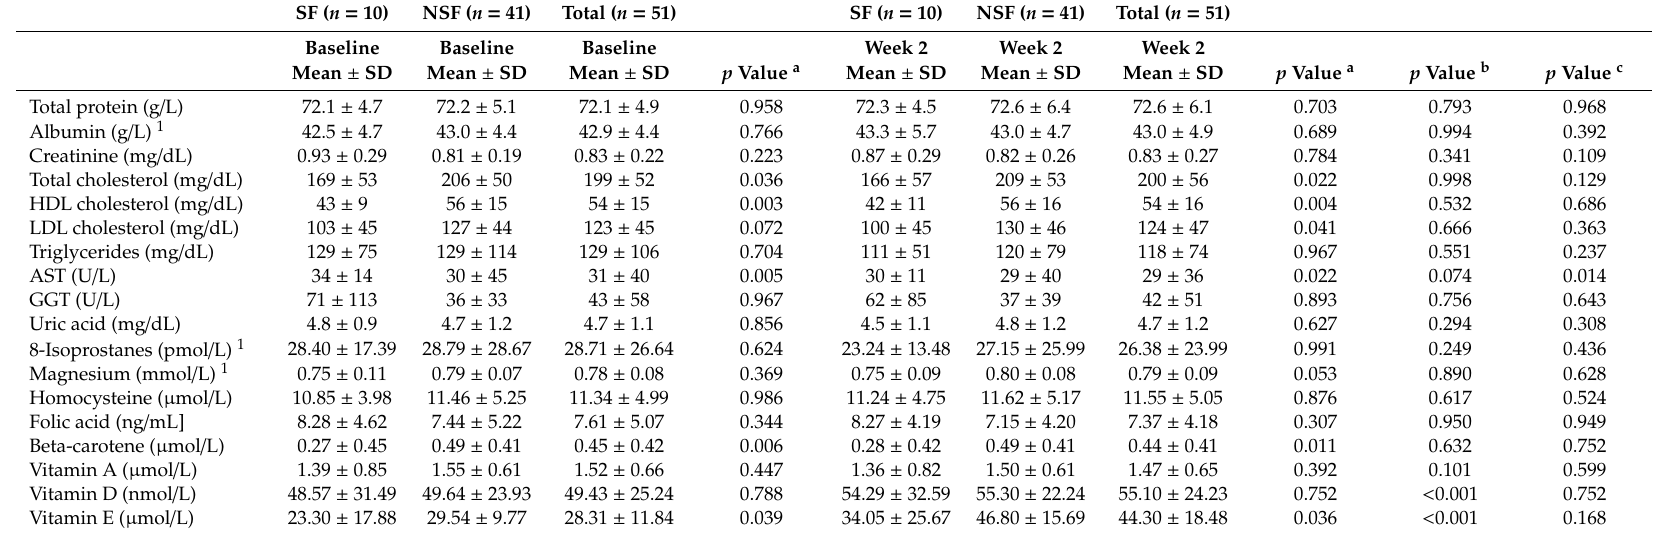
Table 2. Clinical chemistry and biochemical characteristics of stone formers and non-stone formers at baseline and after ADEK